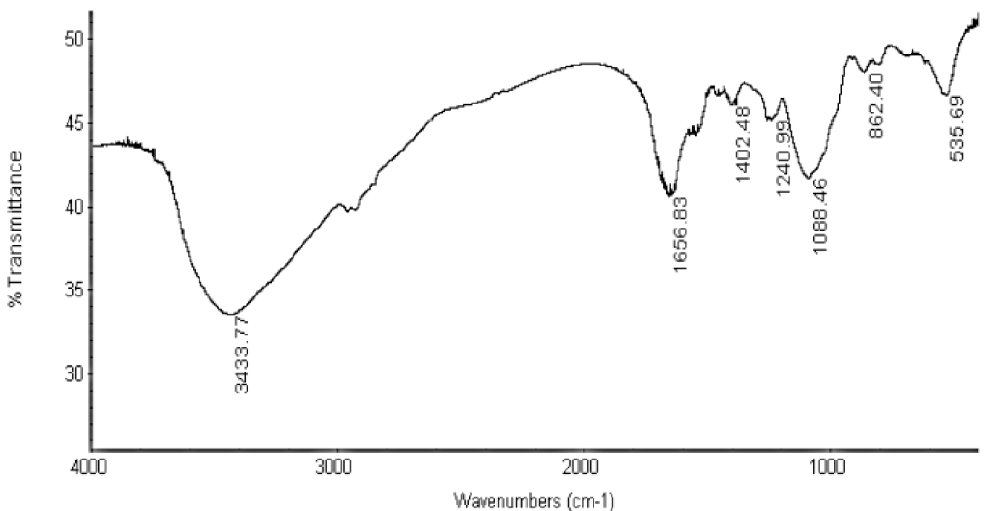
Figure 2. Fourier transform infrared (FTIR) spectrum of the MOE6-EPS in the range of 400–4000 cm − 1 showing common bands which are characteristic for polysaccharides.